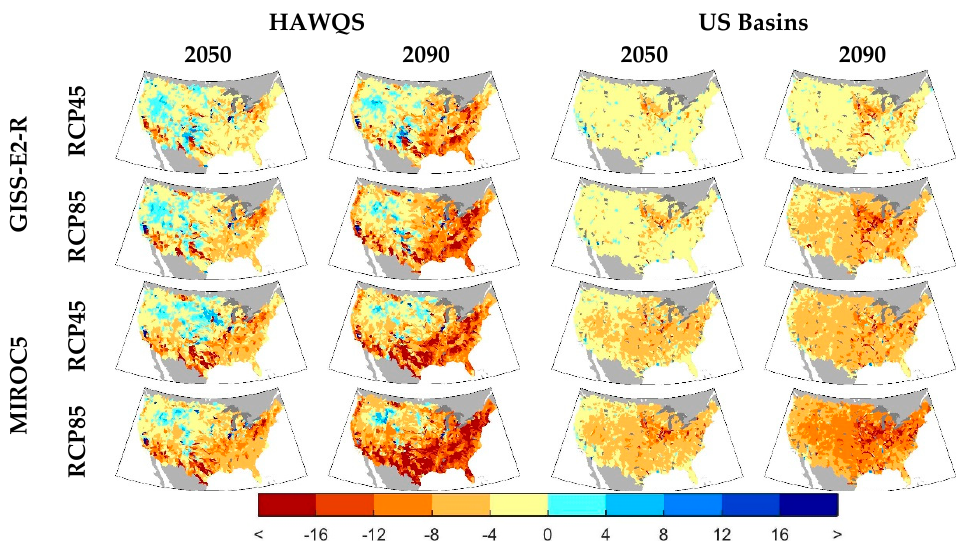
Figure 10. Percentage changes in mean ( left ) HAWQS and ( right ) US Basins dissolved oxygen for, at the HUC ‐ 8 watershed scale, both the GISS ‐ E2 ‐ R and MIROC5 climate models, two emissions scenarios, and two eras.